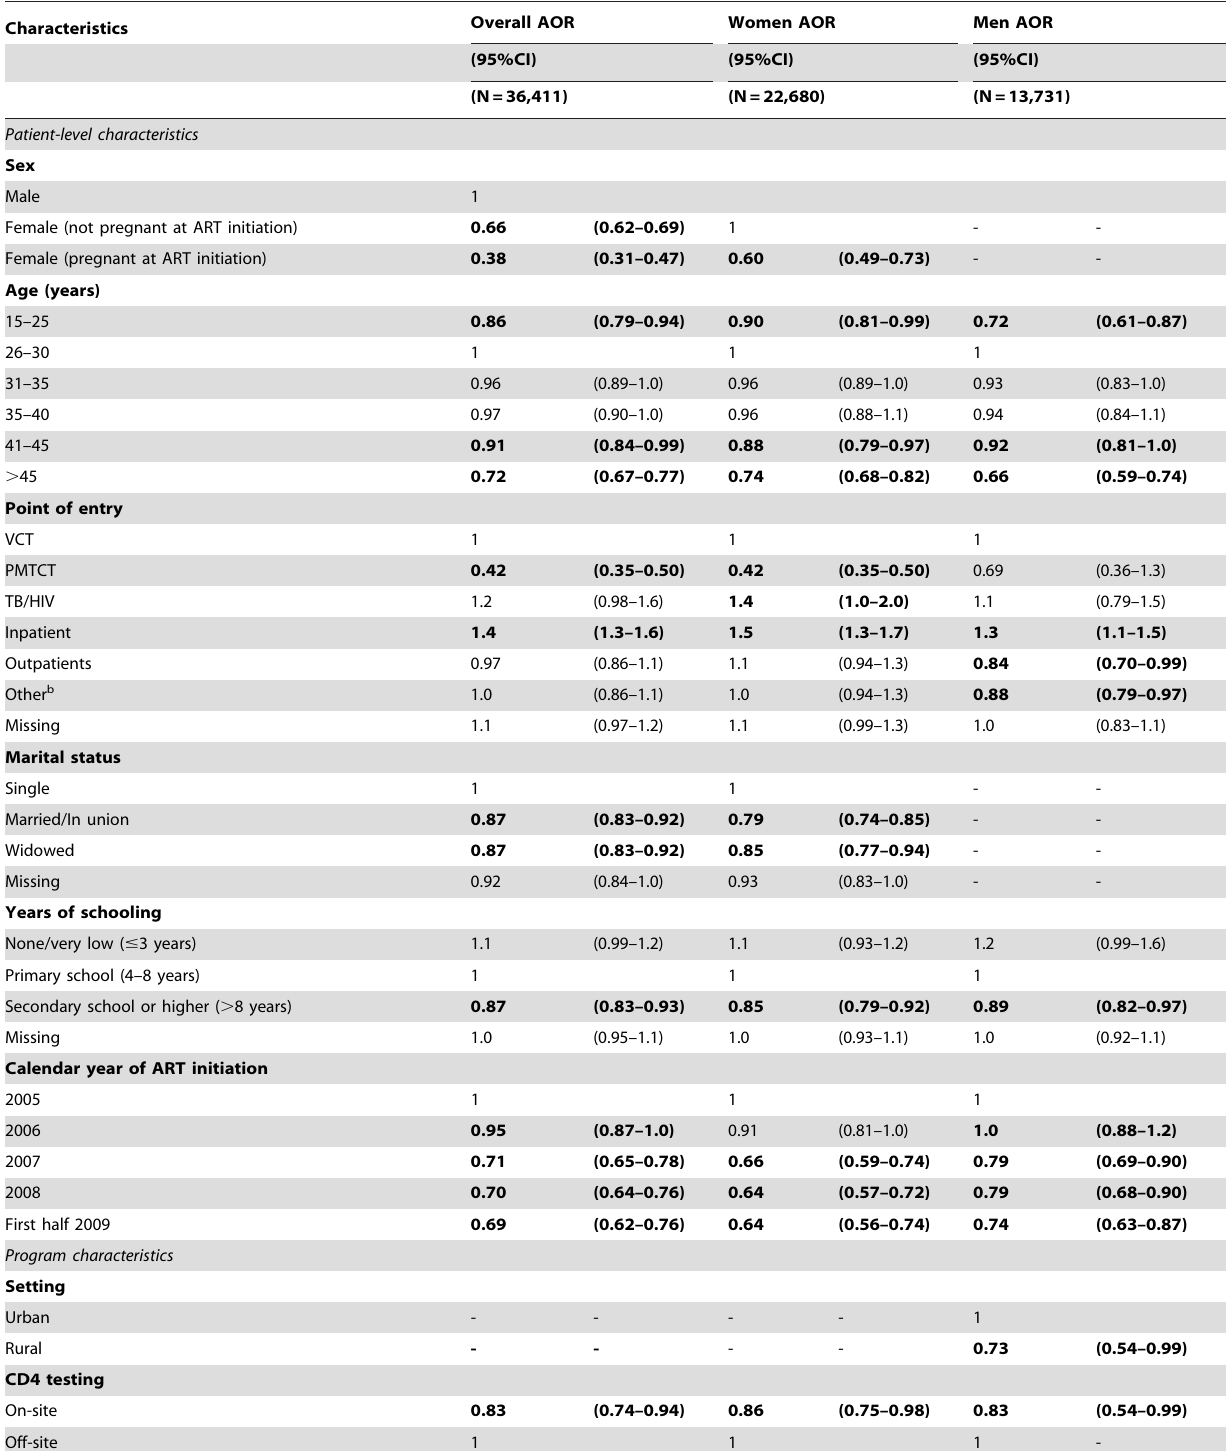
Table 3. Multivariate analysis on factors associated with late ART initiation (CD4 count , 100 cells/ m L or WHO stage IV) stratified by patient gender and adjusting for clustering.